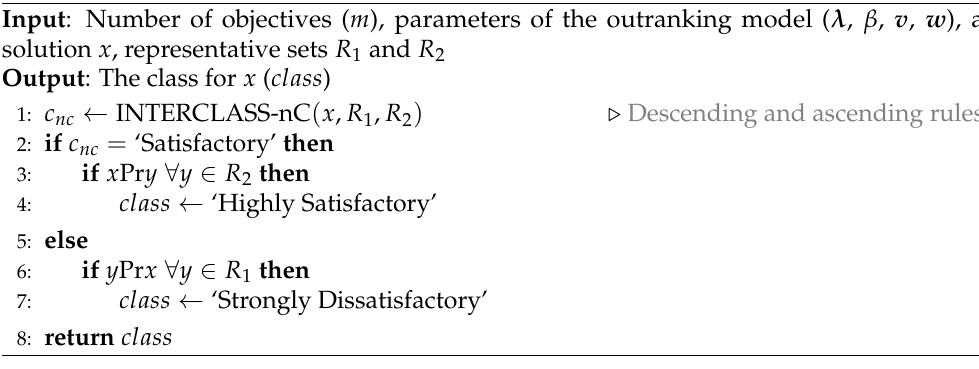
Algorithm 1 Ordinal classifier based on interval outranking